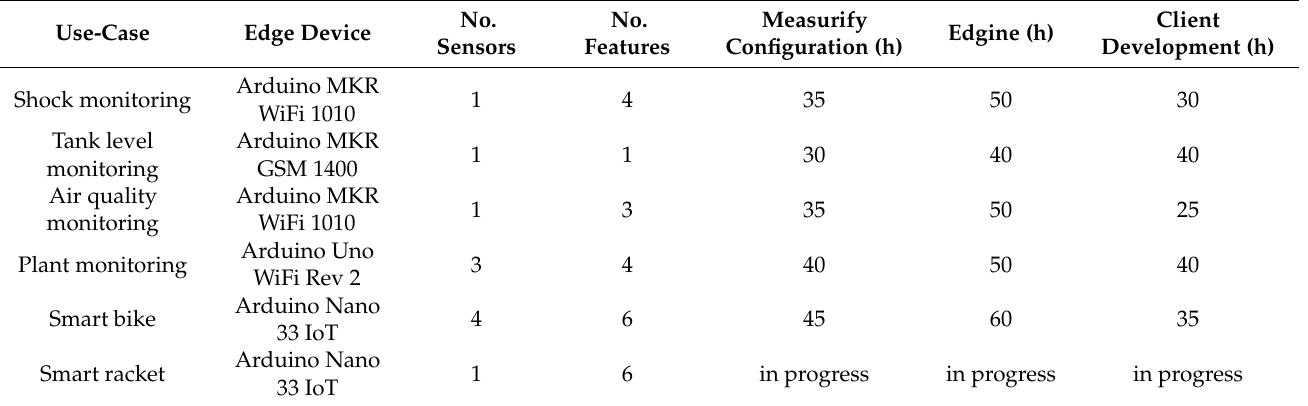
Table 7. Quantitative observation of the presented use-cases.